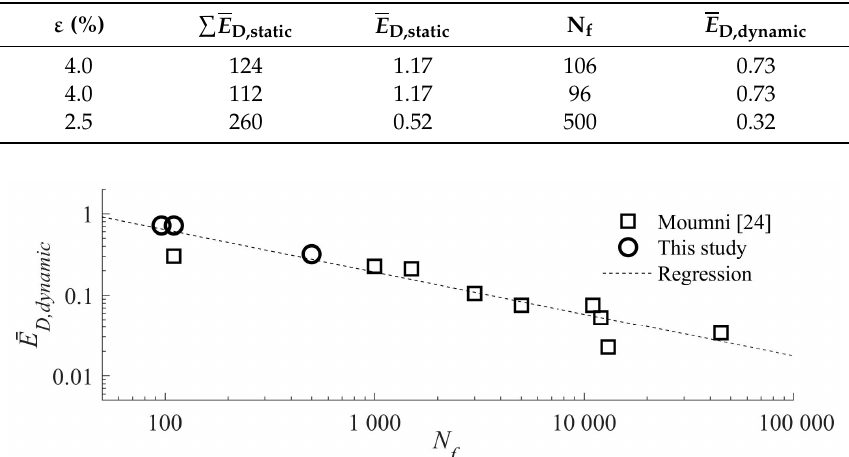
Table 2. Ultimate normalized energy dissipation capacity.